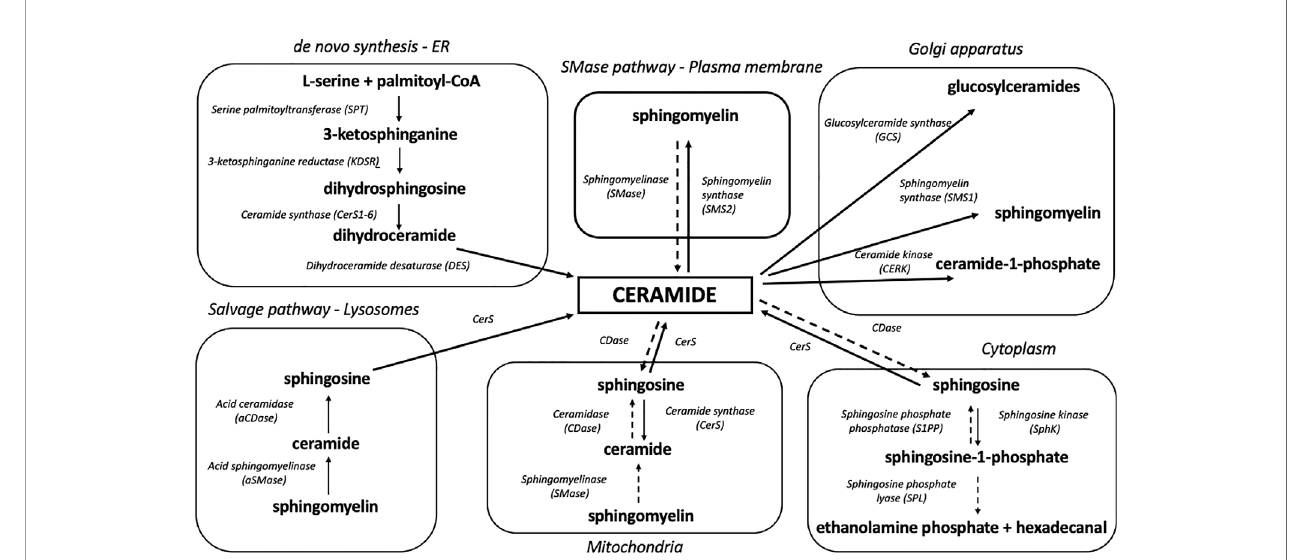
FIGURE 1 | Organelle-speci fi c pathways of sphingolipid metabolism. Due to its highly hydrophobic nature, ceramide is con fi ned to the place of its release at the level of biological membranes. Ceramide degradation yields sphingosine which can shift between intracellular compartments and participate in sphingolipid synthesis in various organelles. Solid arrows denote synthesis reactions, whereas dotted arrows indicate the degradation of a given